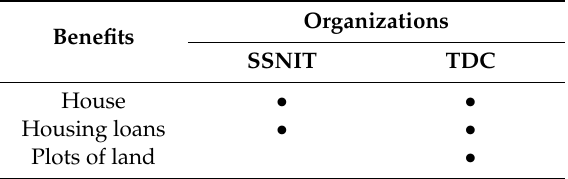
Table 5. Employers’ benefits as supplementary retirement